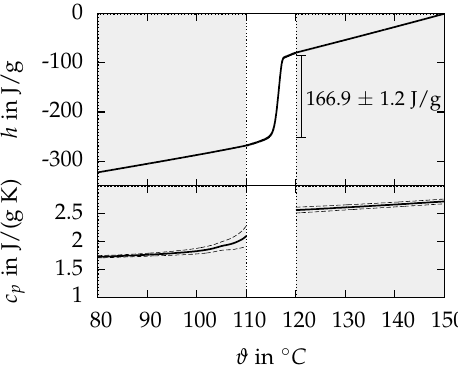
ϑ + d 2 Table 3: Factors for the linear equation c p ( ϑ ) = d 1 · to describe the temperature dependency of the heat capacity of MCHH.